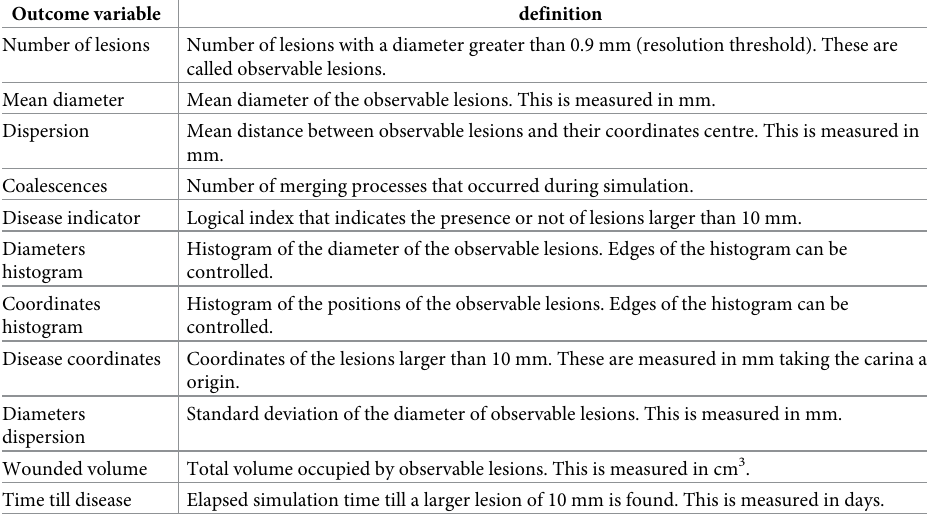
Table 2. Outcome variables of the model. Outcome variable